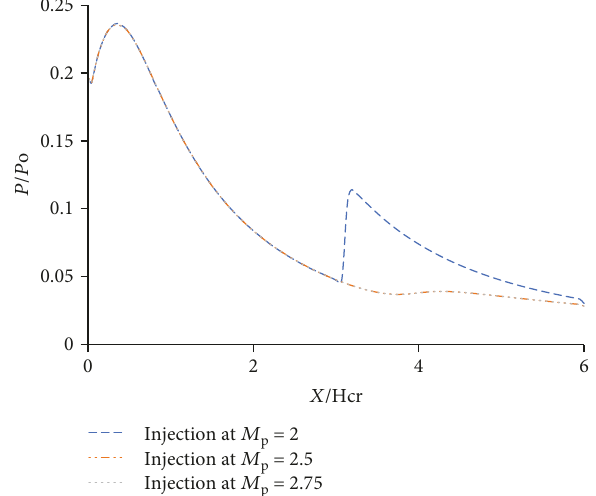
Figure 14: In fl uence of injection location on the static pressure distribution along the lower wall.